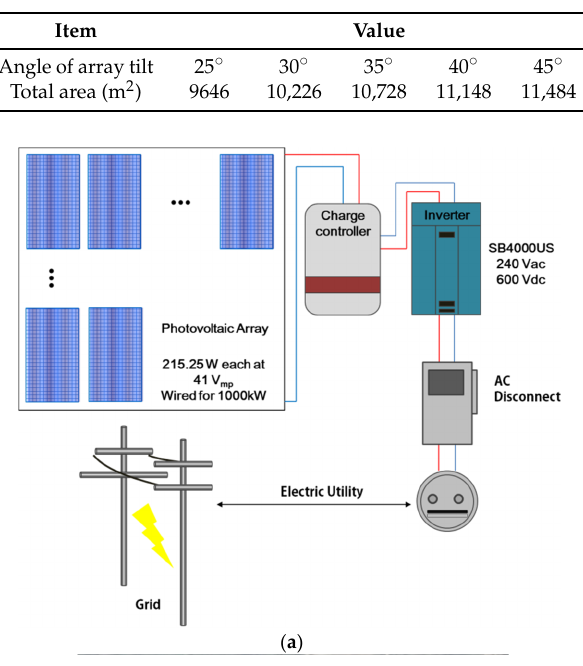
( b ) Figure 5. System design: ( a ) Schematic diagram of the photovoltaic system showing the connections among the PV modules, inverters, and charge controller; ( b ) aerial view of the system layout. Table 6 outlines the monthly and annual electricity production simulated after entering the meteorological data of the solar site, shading matrix (Table 3), and PV ‐ system design parameters (Table 4) into the SAM software. The highest monthly electricity output was in April at all tilt angles, and the lowest was in July due to meteorological characteristics of study site. The highest annual electricity production (971.57 MWh/year) resulted from a tilt angle of 40°. Based on this result, 40° was selected as the optimal tilt angle of the PV array, and the electricity production at the 40° tilt angle was used for the economic and GHG reduction analyses.